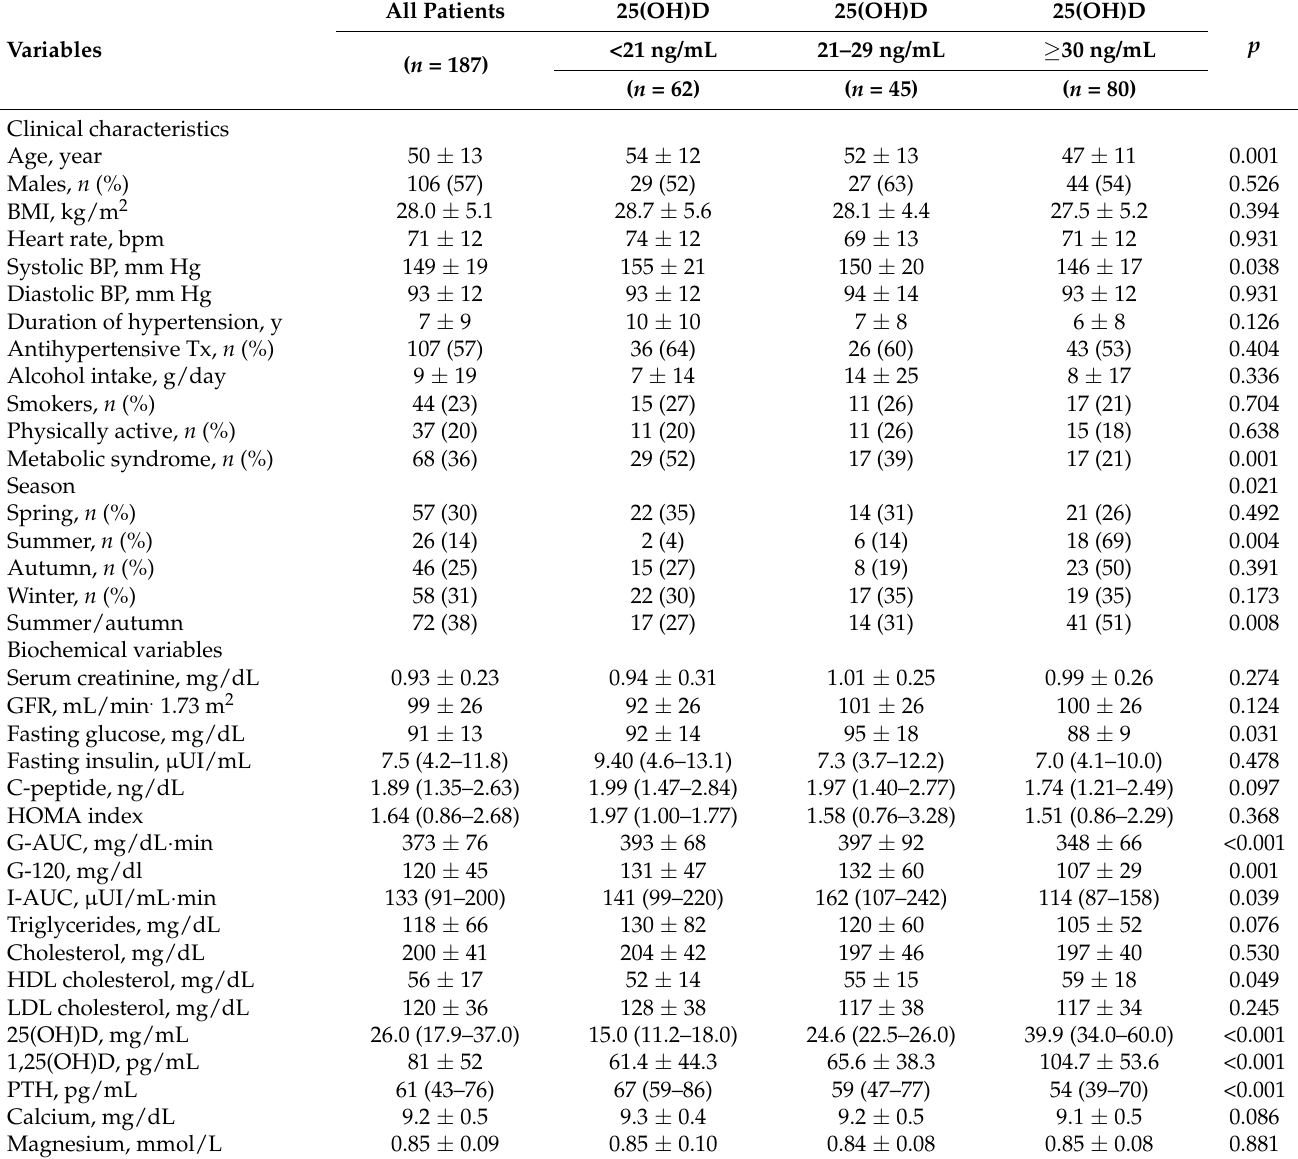
Table 1. Clinical characteristics and biochemical variables of the study patients according to levels of 25(OH) vitamin